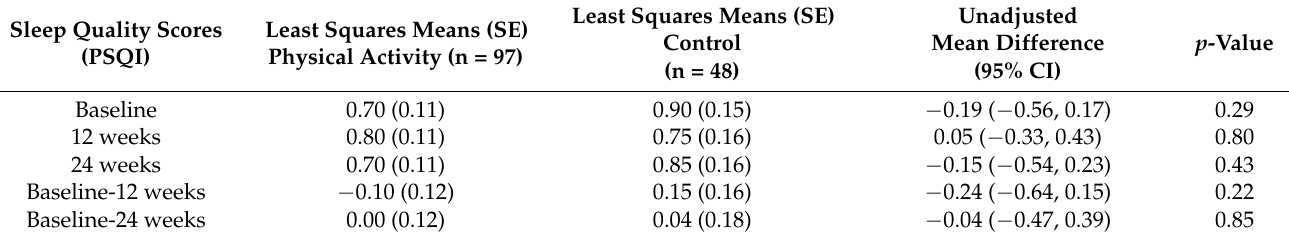
Table A4. Efficiency Component.